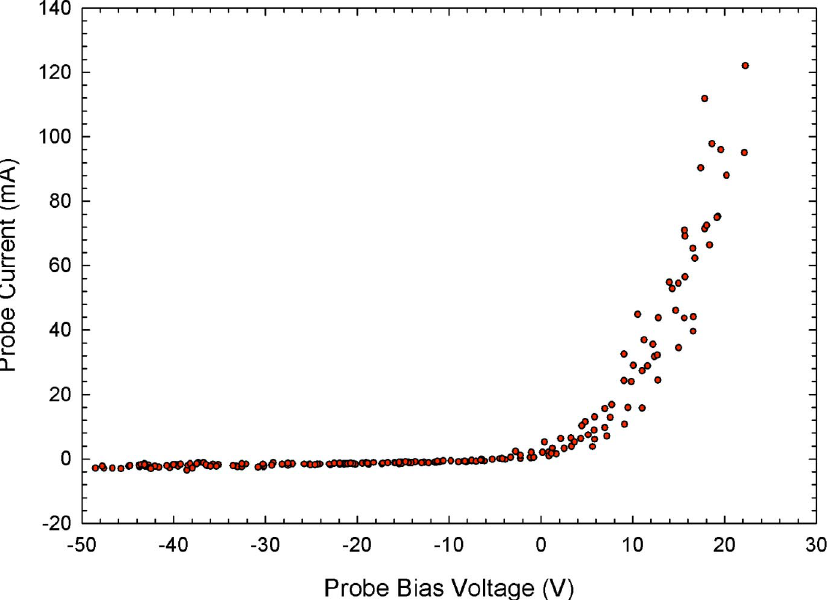
FIG. 27. (Color) Each point on the IV characteristic is taken from a single shot of the cathode-arc plasma source. The shot-to-shot variability produces a spread in the data. The ion saturation current can be used to determine the plasma